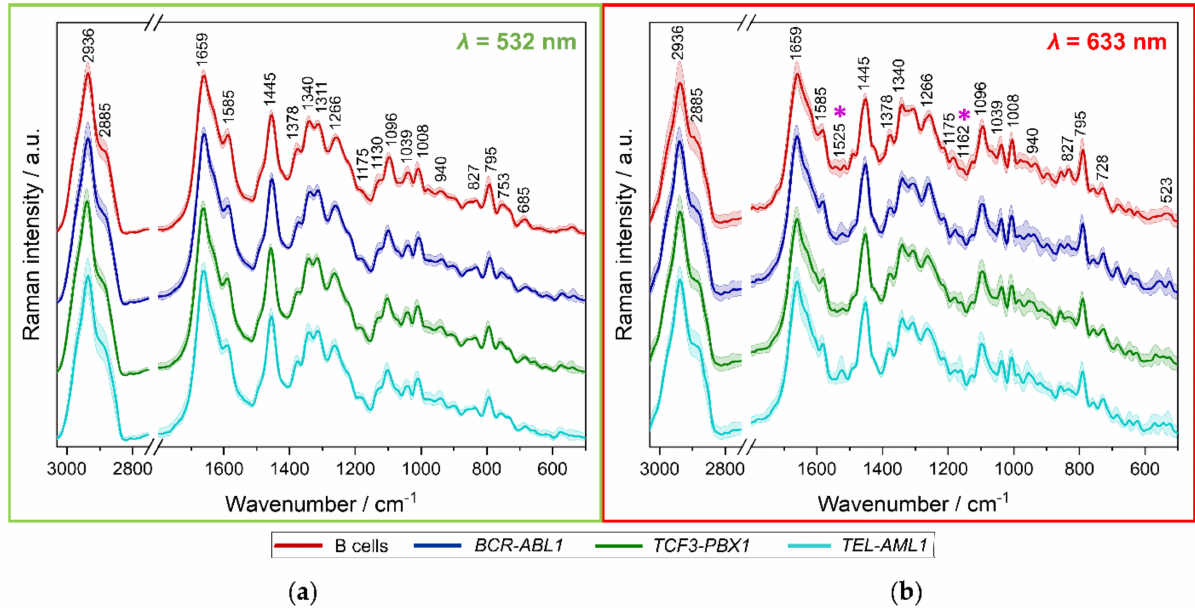
Figure 3. Mean spectra of the whole cells with the standard deviation, measured using a 532 nm laser ( a ) of B cells ( n = 254), and BCR-ABL1 ( n = 183), TCF3-PBX1 ( n = 331), TEL-AML1 ( n = 314) lymphoblasts; and using a 633 nm laser ( b ) of B cells ( n = 247), and BCR-ABL1 ( n = 169), TCF3-PBX1 ( n = 271), TEL-AML1 ( n = 254) lymphoblasts. Spectra were maximally extended on the y axis and shown in the ranges 3050–2750 cm − 1 and 1800–500 cm − 1 . B cells are represented in red color, whereas leukemic cells with BCR-ABL1 fusion gene are in navy blue, with TCF3-PBX1 mutation are in green, and with TEL-AML1 fusion are in turquoise. In panel ( b ), bands at 1525 and 1162 cm − 1 are marked with purple asterisks